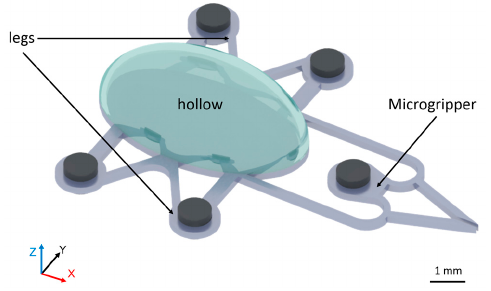
Figure 1. Conceptual overview of the microrobotic system. The robot is actuated by permanent magnets, and works in the aquatic environment of a microfluidic chip.